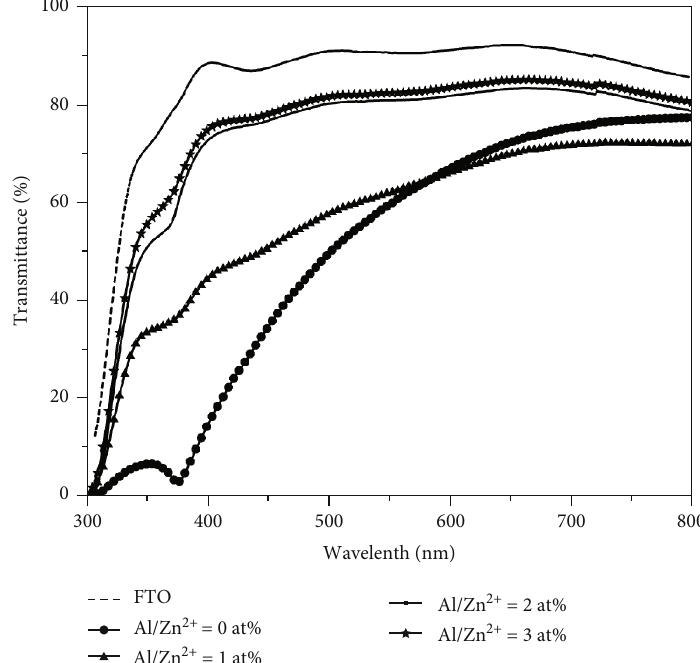
Figure 9: Optical transmittance in the visible light wavelength from 300nm to 800 nm of the FTO glass substrate and the electrodeposited ZnO samples with Al 3+ /Zn 2+ ratio of 0, 1, 2, and 3 at% in the precursors and deposition time of